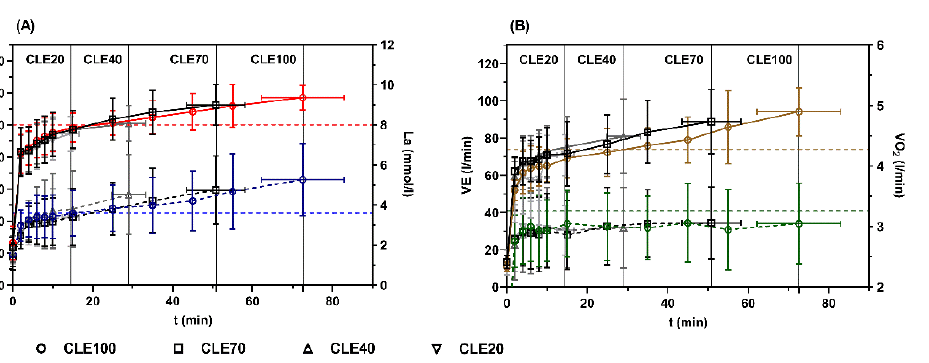
Figure 1. ( A ) Heart rate (HR) (solid lines) and lactate concentration (La) (dashed lines) as well as ( B ) ventilation ( VE) (solid lines) and oxygen uptake ( VO 2 ) (dashed lines) during constant-load cycle ergometer exercise tests (CLE) with maximum duration (CLE100) and 70, 40, and 20% (CLE70, CLE40 and CLE20) of CLE100 at the same intensity determined from a maximal incremental cycle ergometer exercise test (10% of P max below PLTP 2 ). Vertical dotted lines mark the peak duration of the single CE tests. Dashed horizontal lines indicate the mean values for HR (red), La (blue), VE (brown), and VO 2 (green) at the second threshold from the maximum incremental cycle ergometer test.